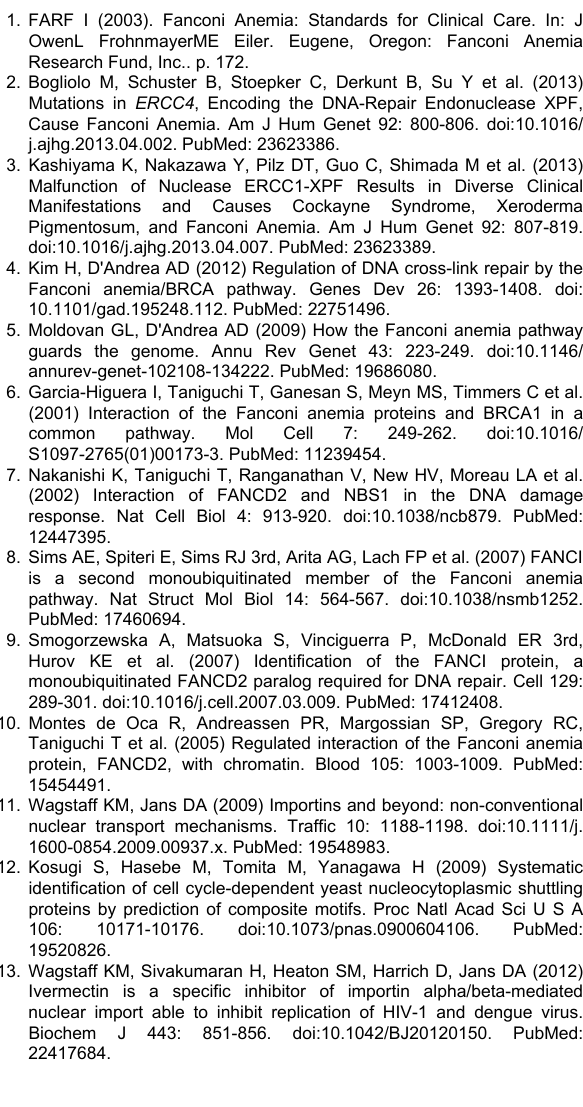
Figure S4. The FANCD2 NLS deletion mutants fail to rescue the MMC sensitivity of FA-D2 cells. FA-D2 cells stably expressing FANCD2-WT, FANCD2-K561R, FANCD2- ∆N57, FANCD2-∆N100, or FANCD2-3N were treated with the indicated concentrations of MMC for 7-10 days. Cells were fixed and stained with crystal violet and percent survival calculated and plotted. Each measurement was performed in triplicate and experiments were performed multiple times with similar results. The 20% trimmed means ( ) for all recorded 20% measurements were calculated and plotted. Error bars represent the standard errors of the means.